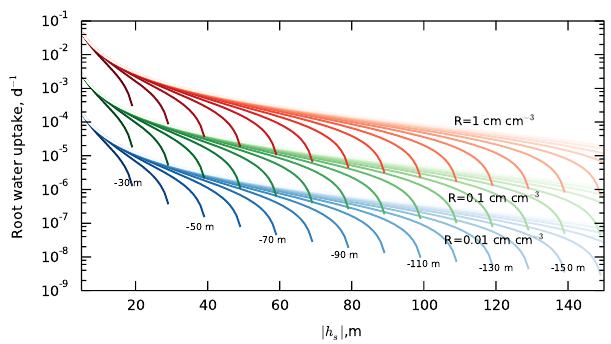
Figure 2. Root water uptake (RWU) as a function of soil pres- sure head h s for three values of root length density (0.01, 0.1, and 1.0cmcm − 3 ) and leaf pressure head values ranging from − 30 to − 200m by a − 10m interval shown by a colour gradient (lighter colours indicate lower values; some values are indicated in the plot). Results were obtained by the analytical solution of Eq. (8) given by De Jong van Lier et al. (2013) for a special case of Brooks and Corey (1964) soil. Plant transpiration was set to 1mmd − 1 and the soil and plant hydraulic parameters were taken from De Jong van Lier et al.